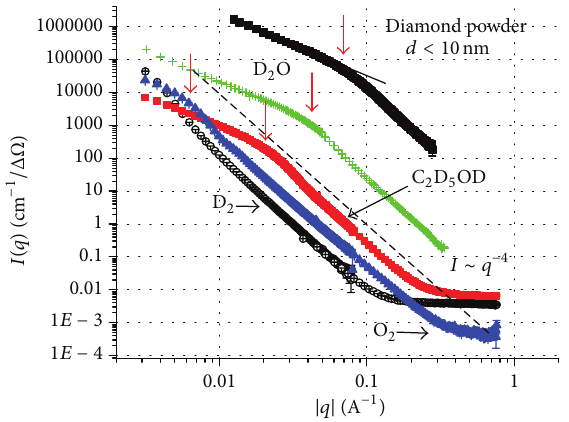
Figure 1: The intensity of small angle neutron scattering on impurities-helium gel samples and diamond